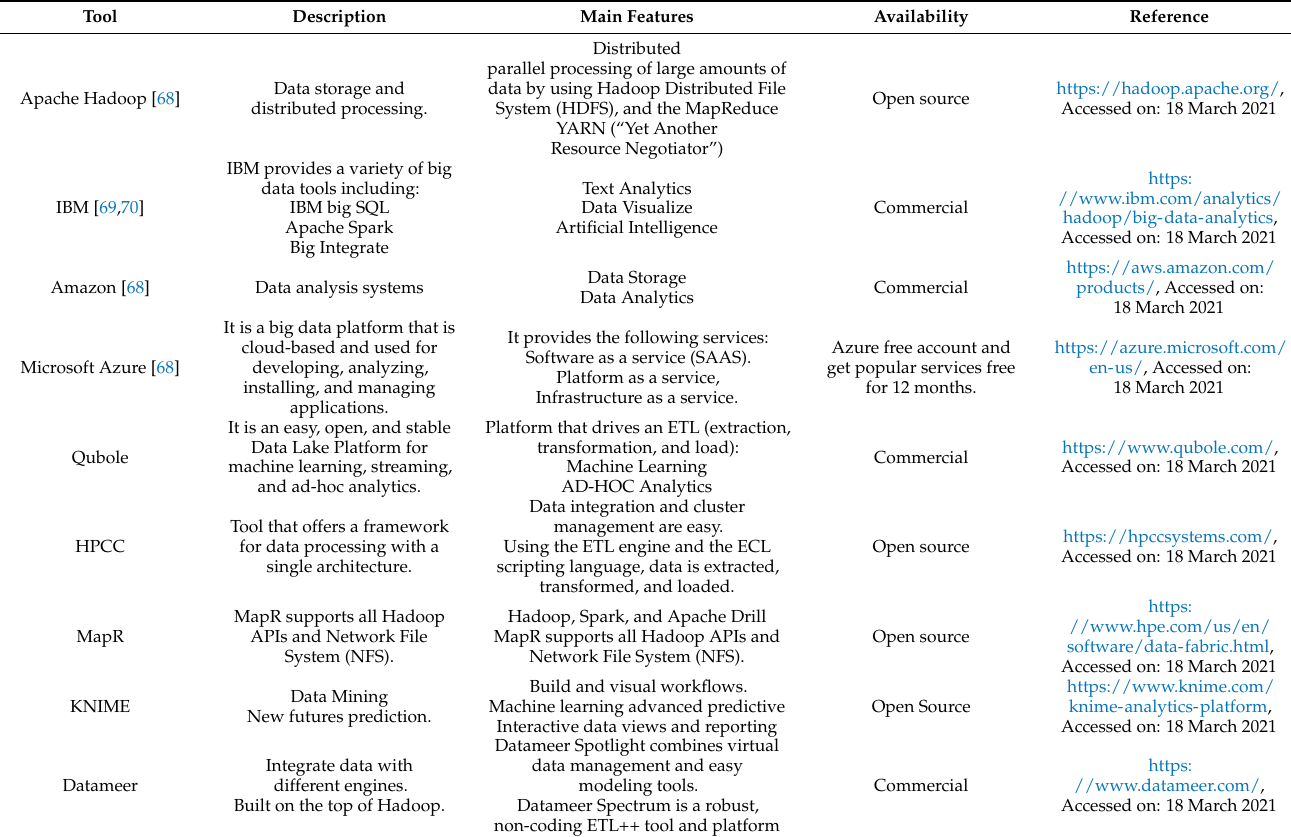
Table 3. Most popular big data analytics tools.